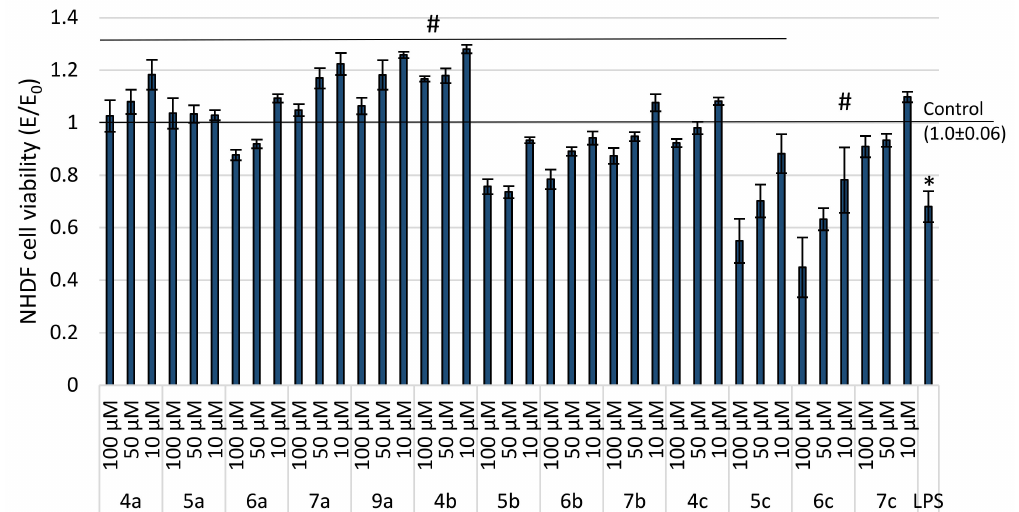
Figure 5. Impact of investigated compounds on NHDF cells after incubation with 50 µ g/mL LPS measured through MTT assay; # p < 0.05—significant difference compared to the control with 50 µ g/mL LPS and without compounds; * p < 0.05—significant difference compared to a negative control without 50 µ g/mL LPS and